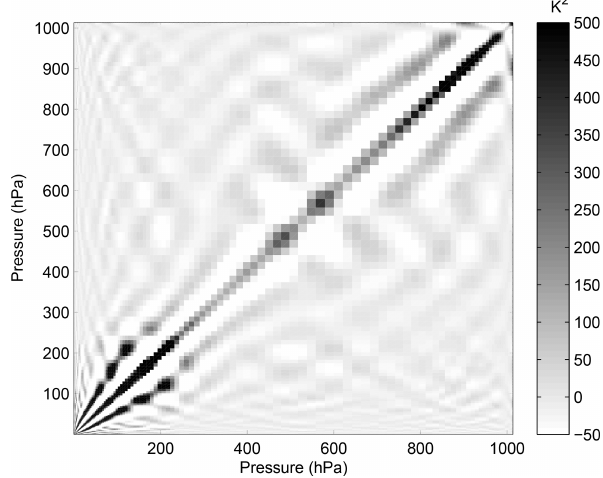
Figure 2. Error covariance matrix of temperature